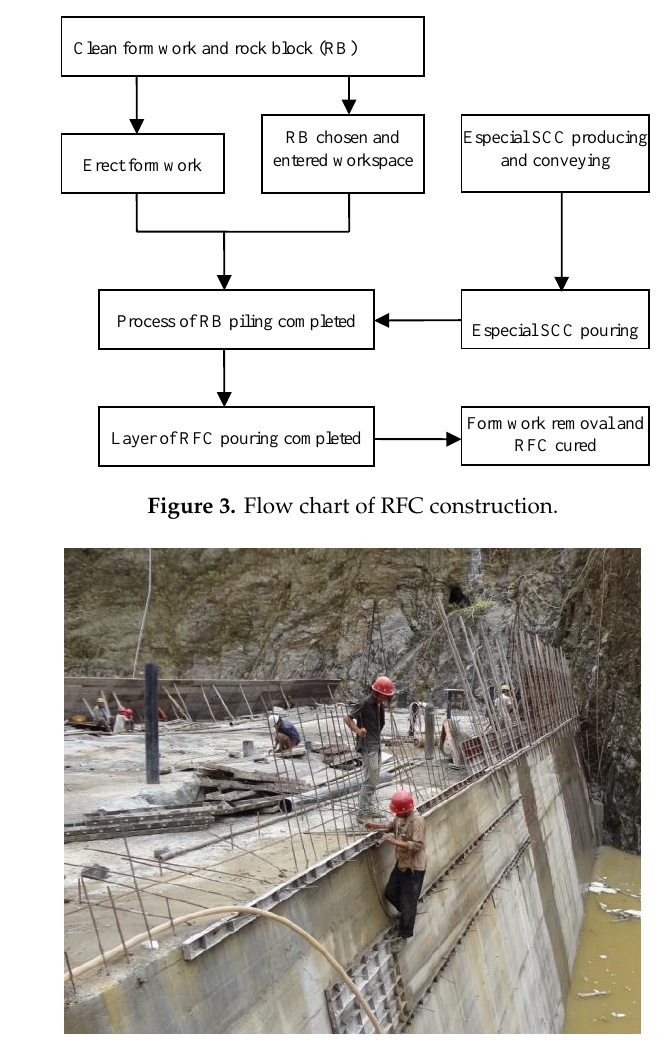
Figure 4. Poured dam body by RFC.